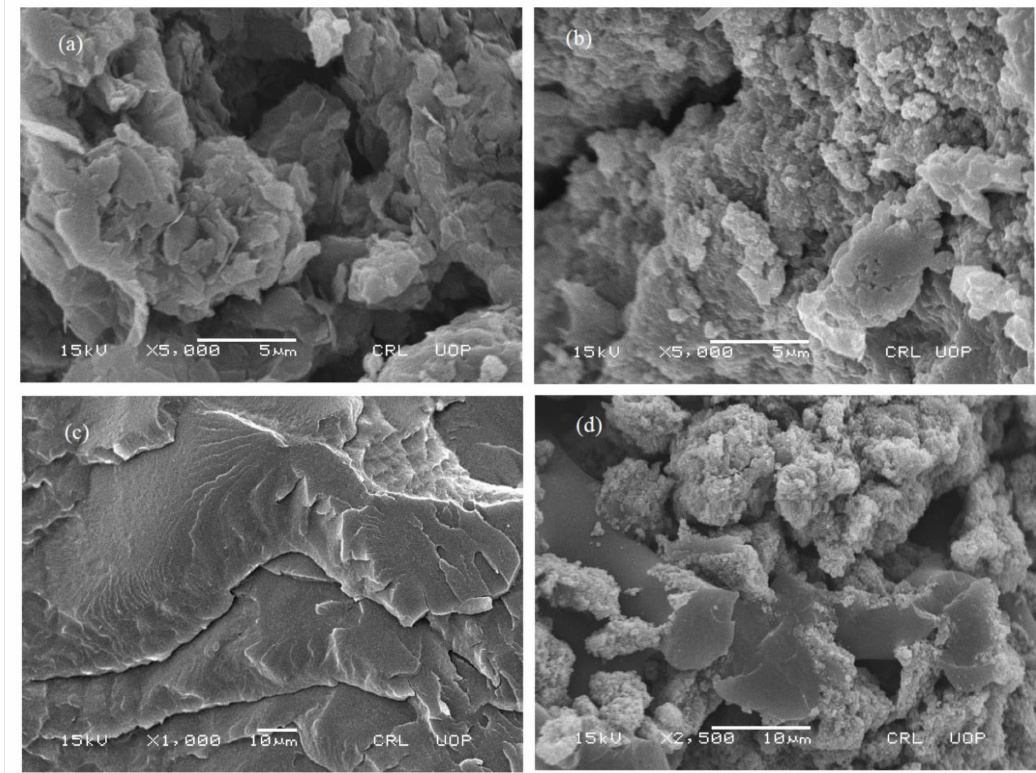
Figure 3. SEM of ( a ) rGO, ( b ) Fe 3 O 4 /rGO, ( c ) PMMA and ( d )